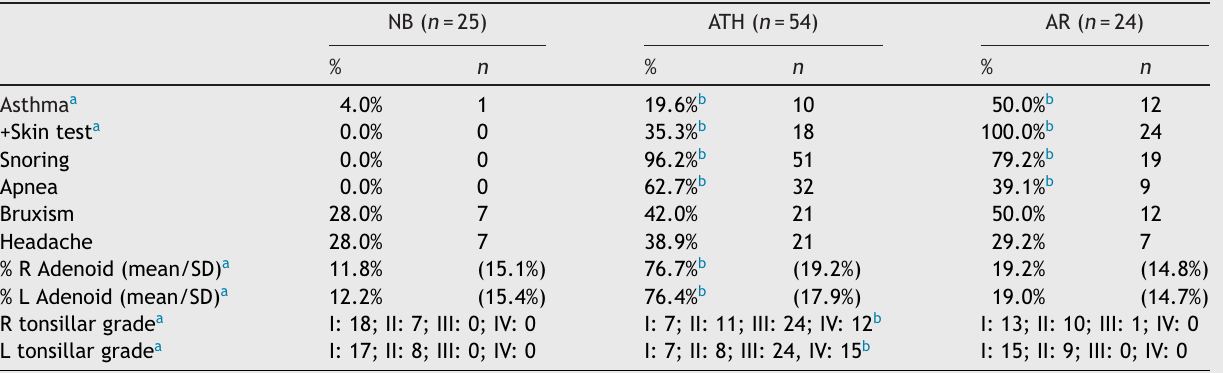
Data obtained from the history and physical examination of patients at the first consultation at the referral